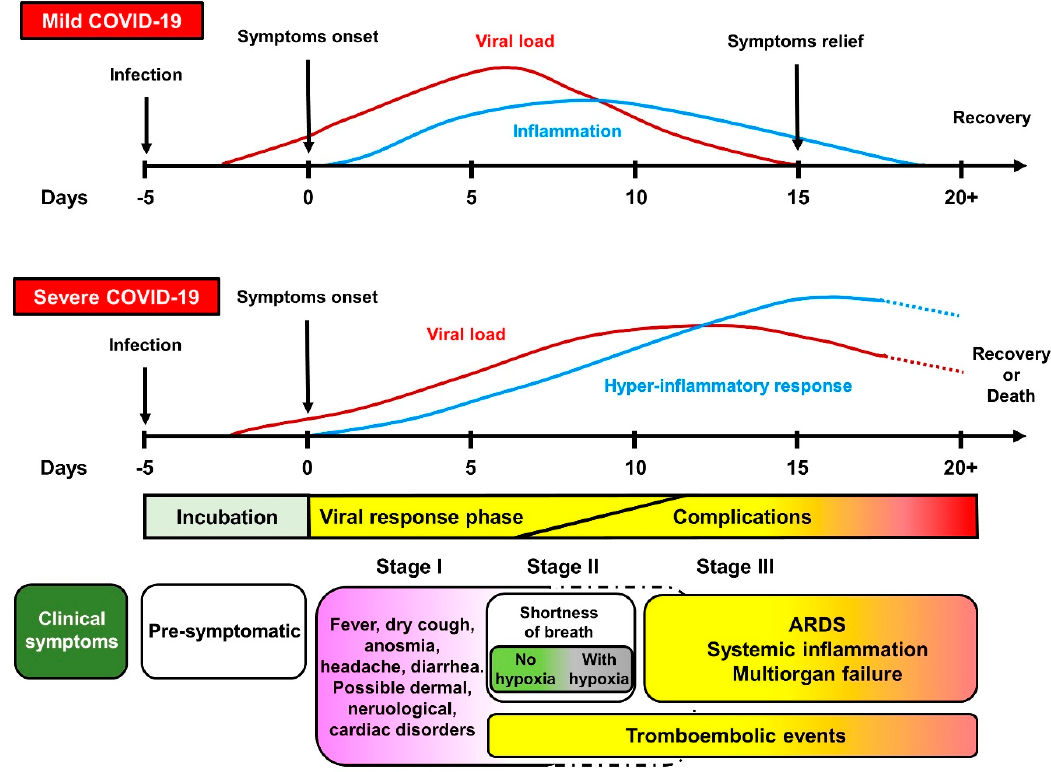
Figure 1. Spectrum and clinical stages of COVID-19. Clinical symptoms that correlate the disease course were scaled to the average days and time windows at which they typically occur. In general, the incubation period is on average 5 days from SARS-CoV-2 infection. Most people will experience mild to heavy symptoms during Stage I (which roughly correlate with peaks in viral load and inflammatory response) and no complications. Severe COVID-19 is instead characterized by a hyper-inflammatory response that incites disease progression toward Stage II and III, with acute respiratory distress syndrome (ARDS), multiorgan failure, and coagulation disorders as main causes of